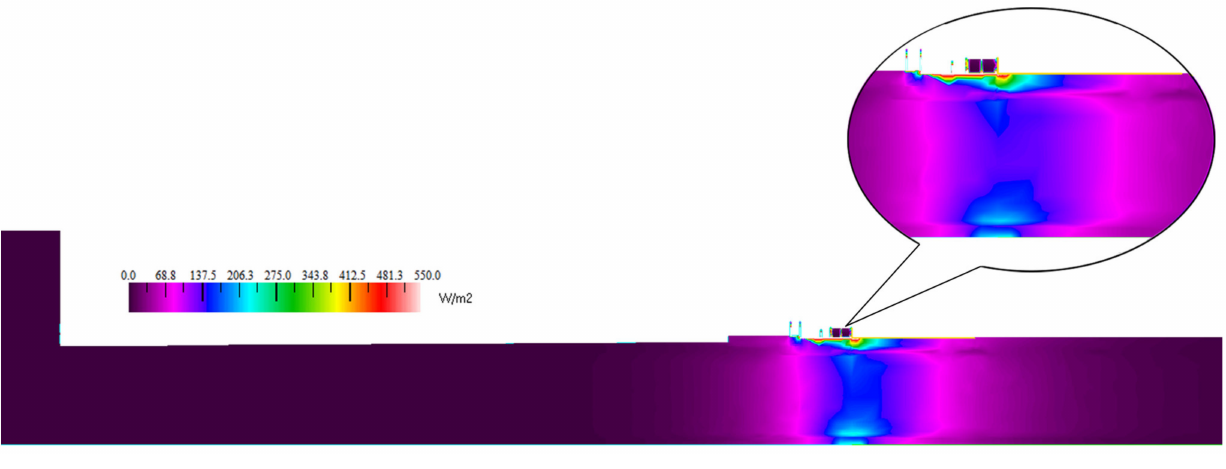
Figure 3. Two-dimensional heat transfer simulation analysis at the study